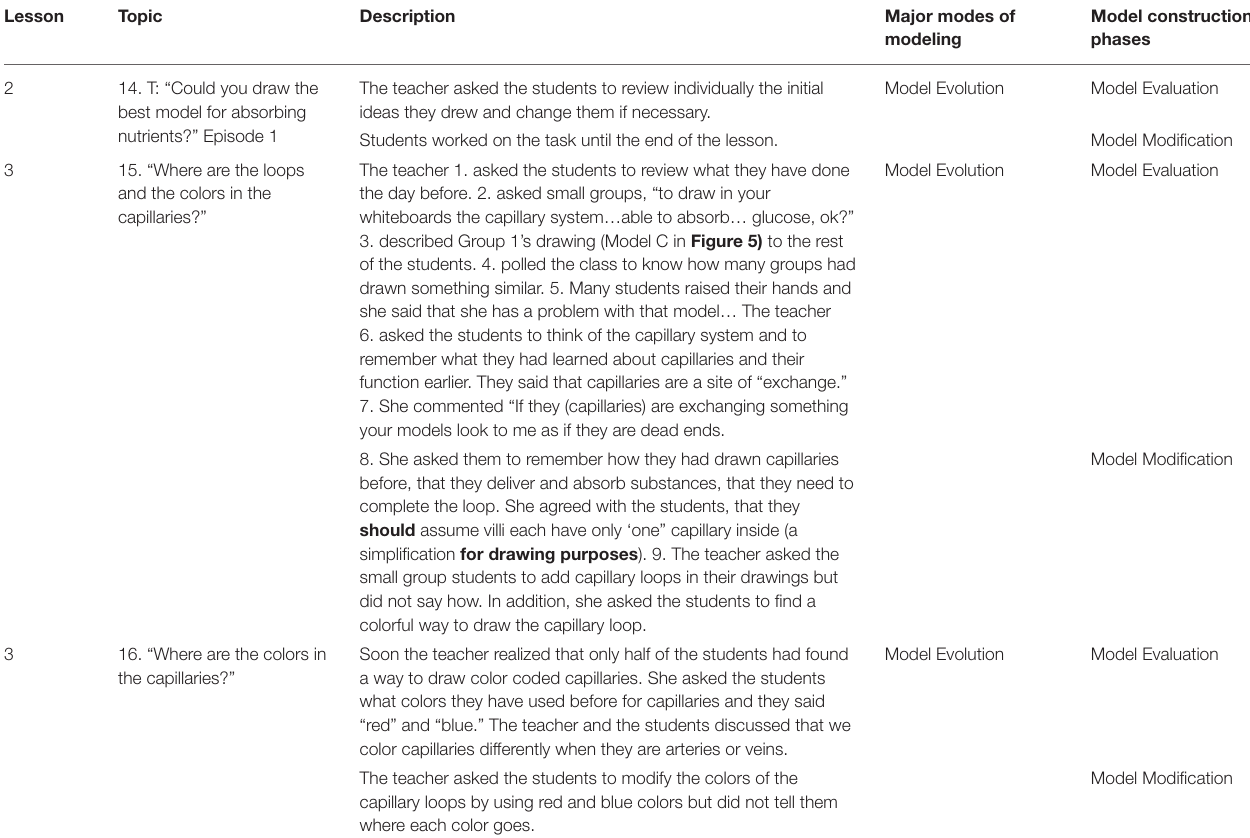
TABLE 6 | Model evolution mode (part 4).